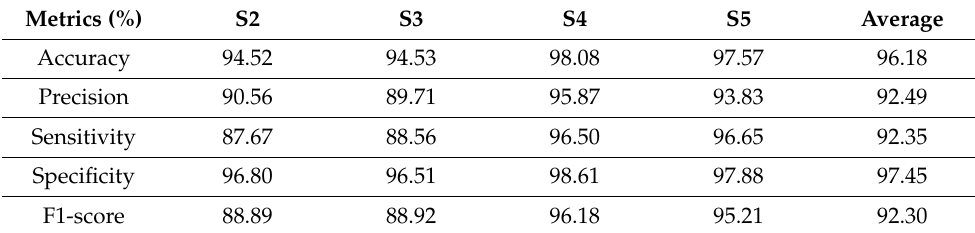
Table 7. The confusion matrix included performance metrics such as accuracy, precision, sensitivity, specificity, and F1-score for each instar stage. Table 7. Performance metric of DenseNet121 using SGD optimizer at each instar stage. Metrics (%) S2 S3